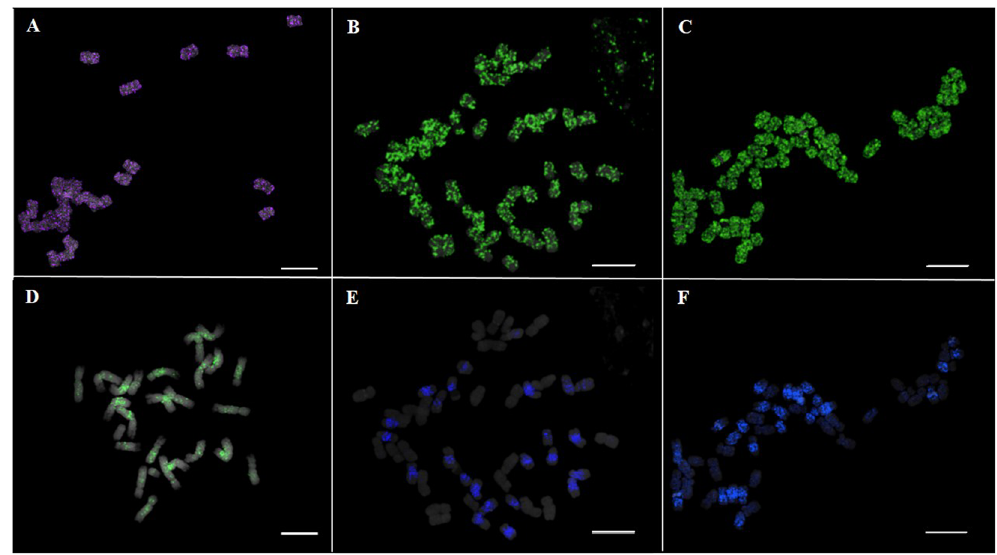
Figure 3. Fluorescence in situ hybridization (FISH) analysis of PgDel1 and PgDel2 distribution in P . ginseng , P . quinquefolius , and P . notoginseng chromosomes. The PgDel1 FISH signals in somatic metaphase chromosomes of ( A ) P . notoginseng (purple), ( B ) P . ginseng , and ( C ) P . quinquefolius . The PgDel2 FISH signals in somatic metaphase chromosomes of ( D ) P . notoginseng , ( E ) P . ginseng (blue), and (F ) P . quinquefolius (blue). Bar = 10 μ